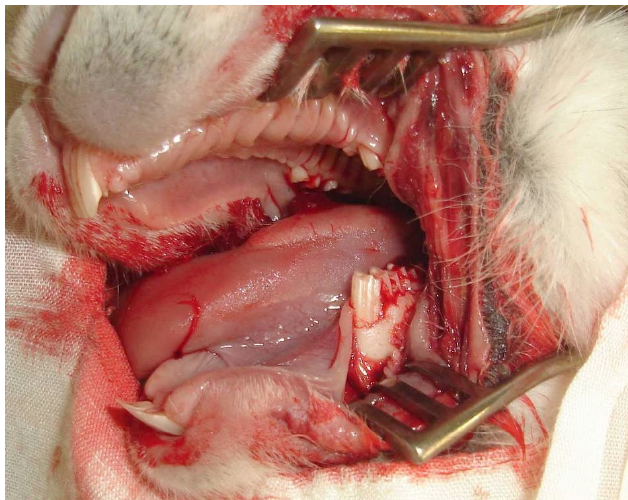
FIGURE 2 – Exposure of the cervical region of teeth and alveolar bone.